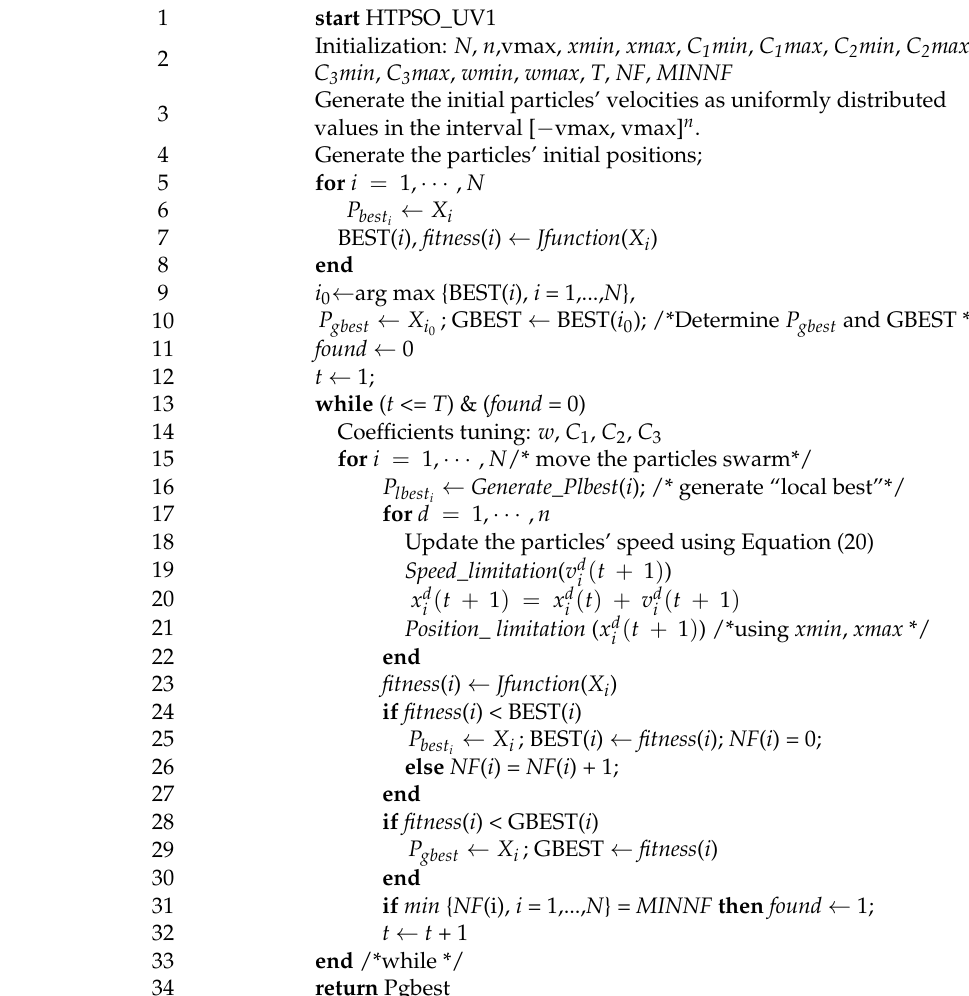
Table 2. Description of algorithm